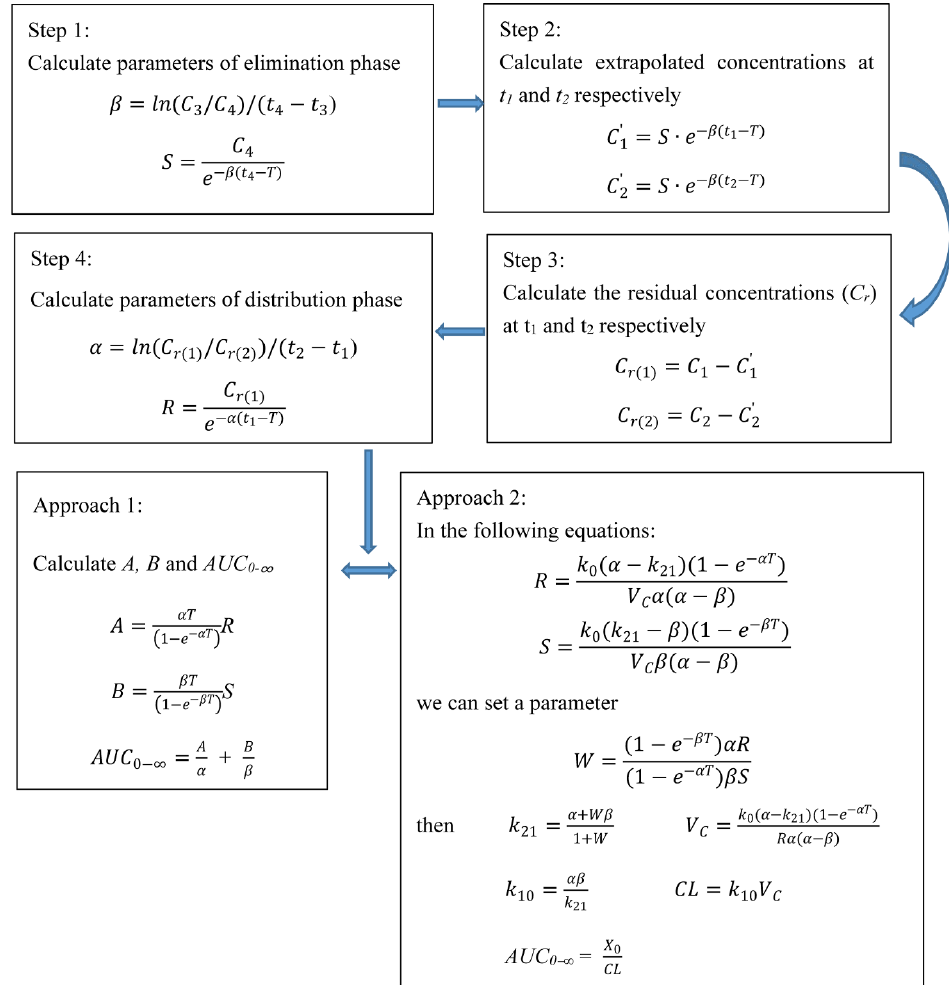
Figure 2. A step-by-step flow-sheet of the equations based on Method 1 to calculate the area under the curve ( AUC 0 –∞ ) of vancomycin. α and β are the respective rate constants represent distribution and elimination phases, Τ is the infusion time. C ′ is the extrapolated concentration. C r is the residual concentration. V C is the volume of distribution of the central compartment, k 21 is intra-compartmental rate constant, and A and B are intercepts for distribution and elimination phases. k 10 is the elimination rate constant from the central compartment, X 0 is the dose.